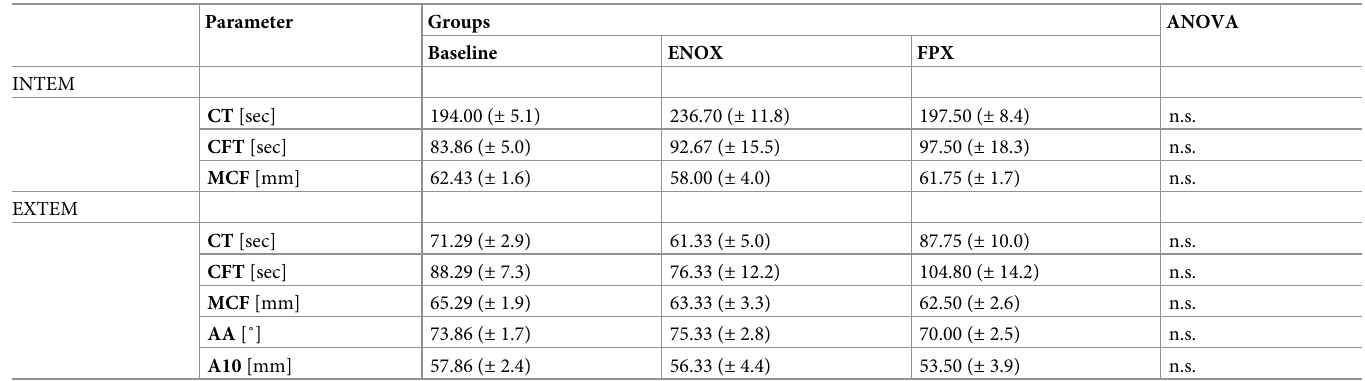
Table 1. Changes in ROTEM due to incubation with fondaparinux or enoxaparin. Parameter